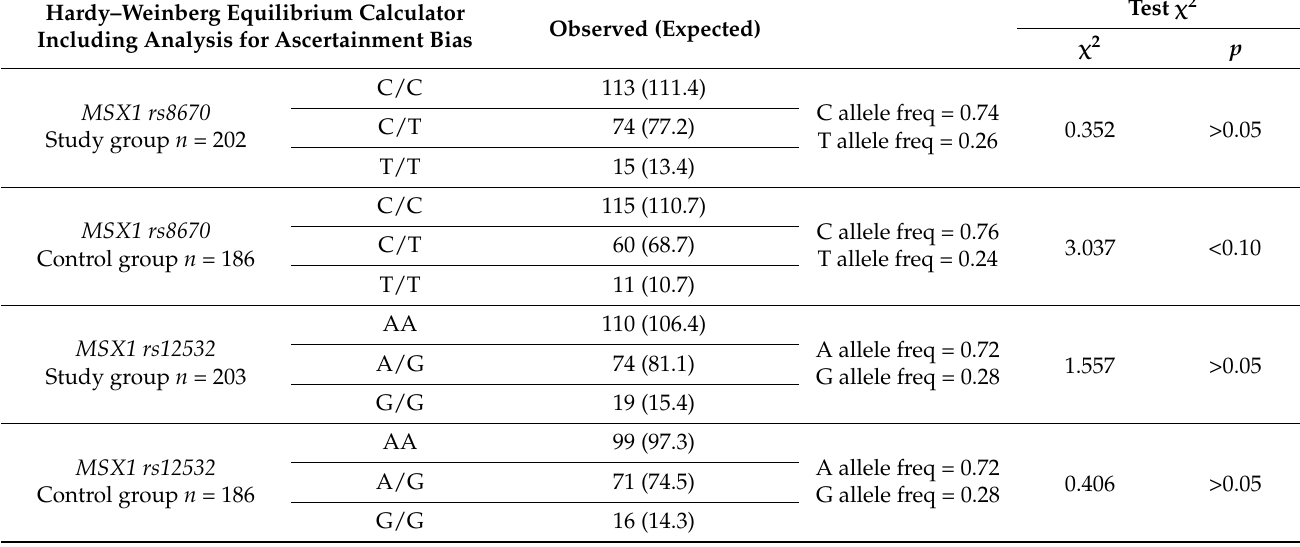
Table 4. Hardy–Weinberg’s law for the study and control group. Hardy–Weinberg Equilibrium